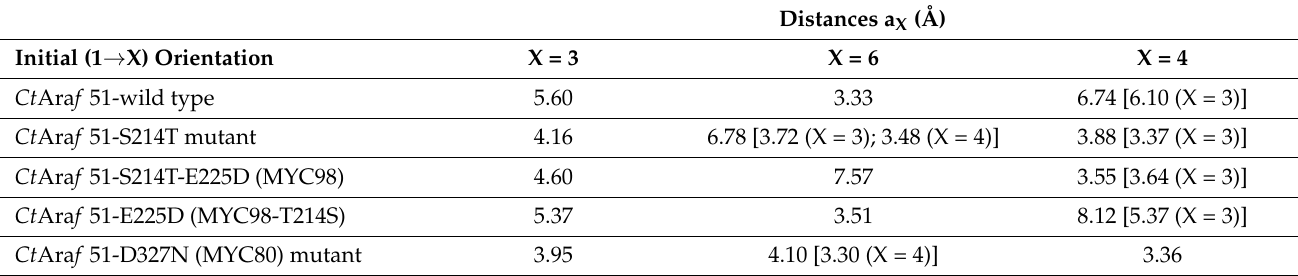
Table 2. MD simulation parameters to study (1 ⟶ X) regioselectivity of Man p ‐ p NP approaches. Distances a X are depicted in Scheme 2. When shorter distances a X were observed with other hydroxyl (OH) than the initial one, they were added between brackets.